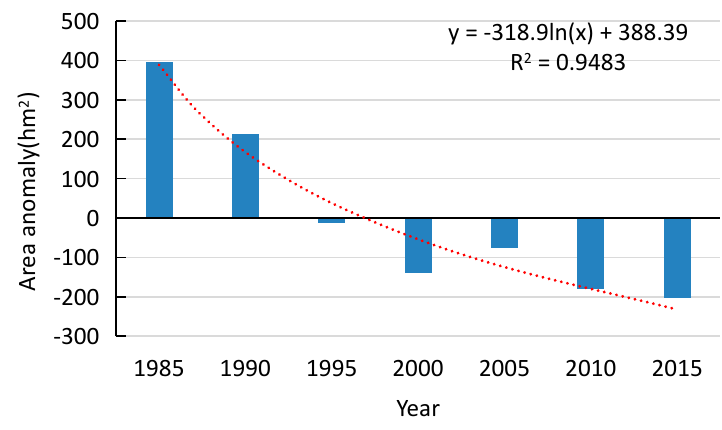
Figure 6. Area anomaly of the seven river islands in the study area (hm 2 ).